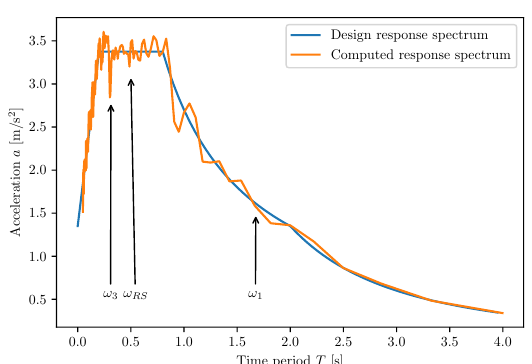
Figure 3. An example of stationary (original) and modulated (with rise, strong motion and decline stages) accelerograms.